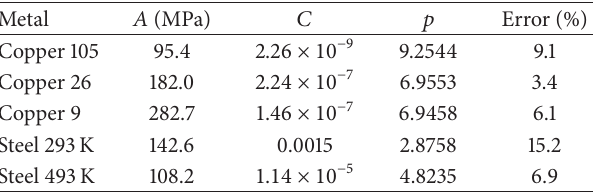
Table 4: Material constants and errors obtained by Tuazon et al.